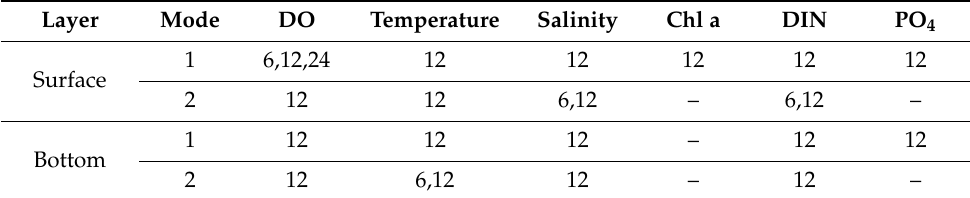
Table 3. Main period(s) of RPCs (units: months).